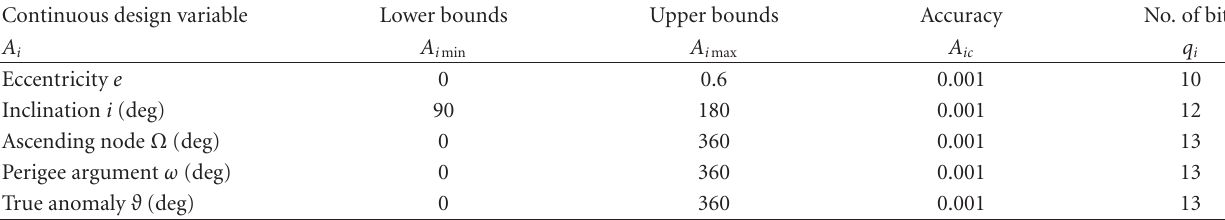
Table 1: The values of the lower and upper bounds, accuracy, and number of bits for each continuous design variable.